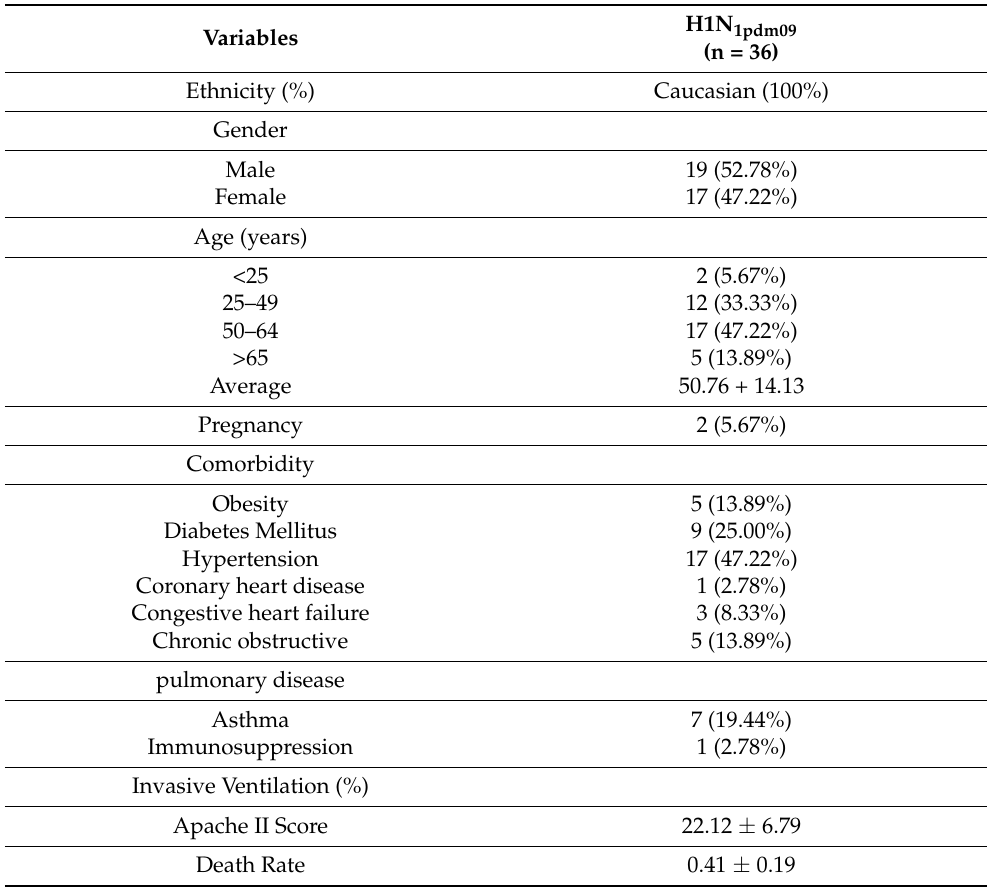
Table 1. Characteristics of the studied patients with confirmed H1N1 pdm09